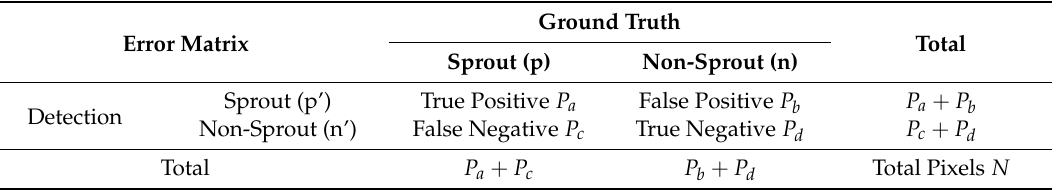
Table 3. Error Matrix of Cohen’s kappa.